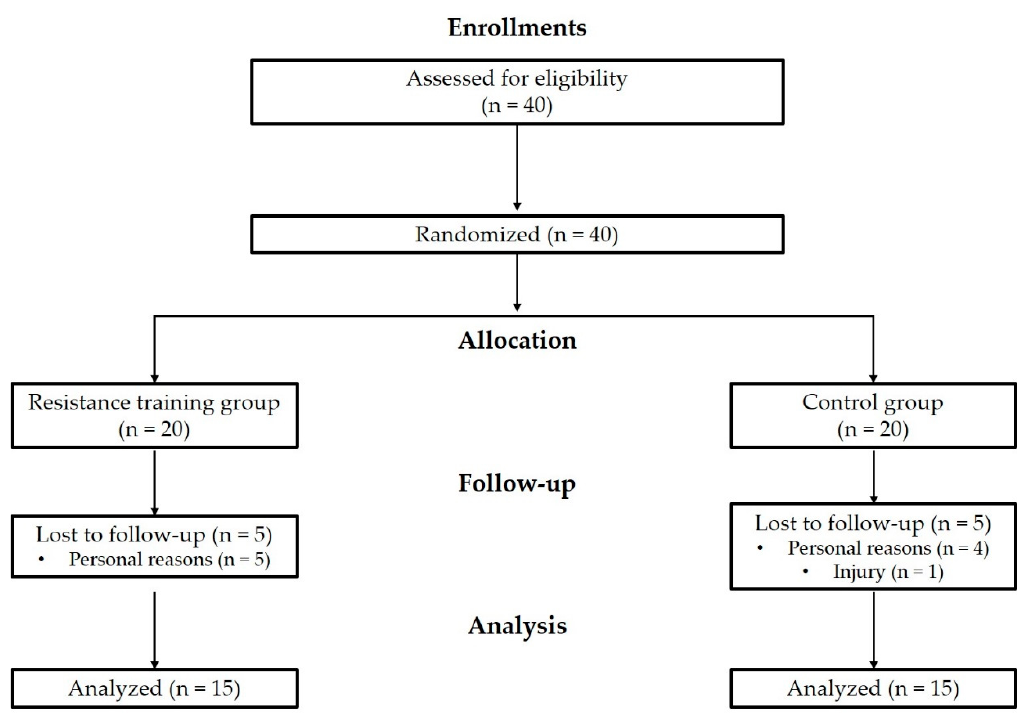
Figure 1. Flow chart of the study. Table 1. Physical characteristics of participants.